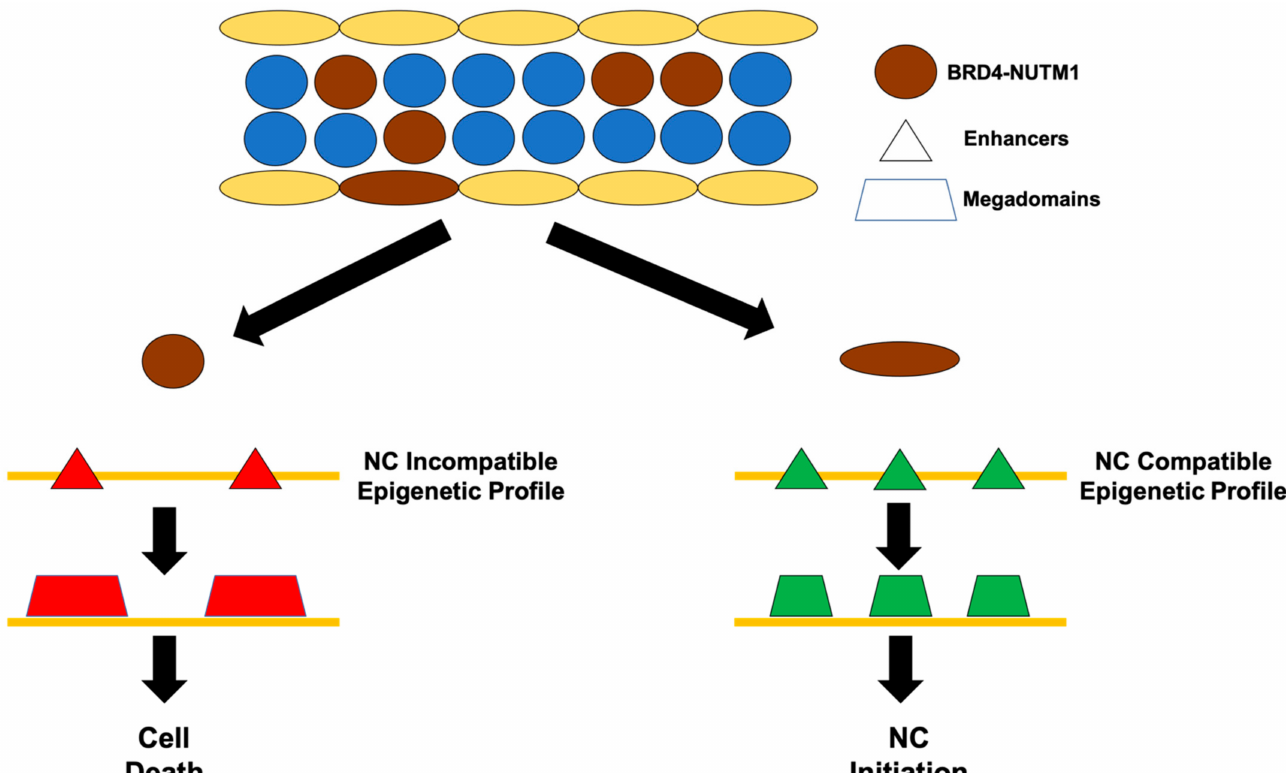
Figure 2. A model of the cell of origin of NC. Most cell types ( left ) possess an epigenetic profile that is not compatible with bromodomain and extraterminal domain BRD4-NUTM1 expression. When the BRD4-NUTM1 fusion proteins are expressed in these cells, it drives the establishment of acetylated histone megadomains that are not compatible with cell survival and causes cell death. Some unknown cell types ( right ) possess an epigenetic profile that is compatible with BRD4-NUTM1 expression. When the BRD4-NUTM1 fusion proteins are expressed in these cells, it drives the establishment of acetylated histone megadomains that cause cell transformation and NC